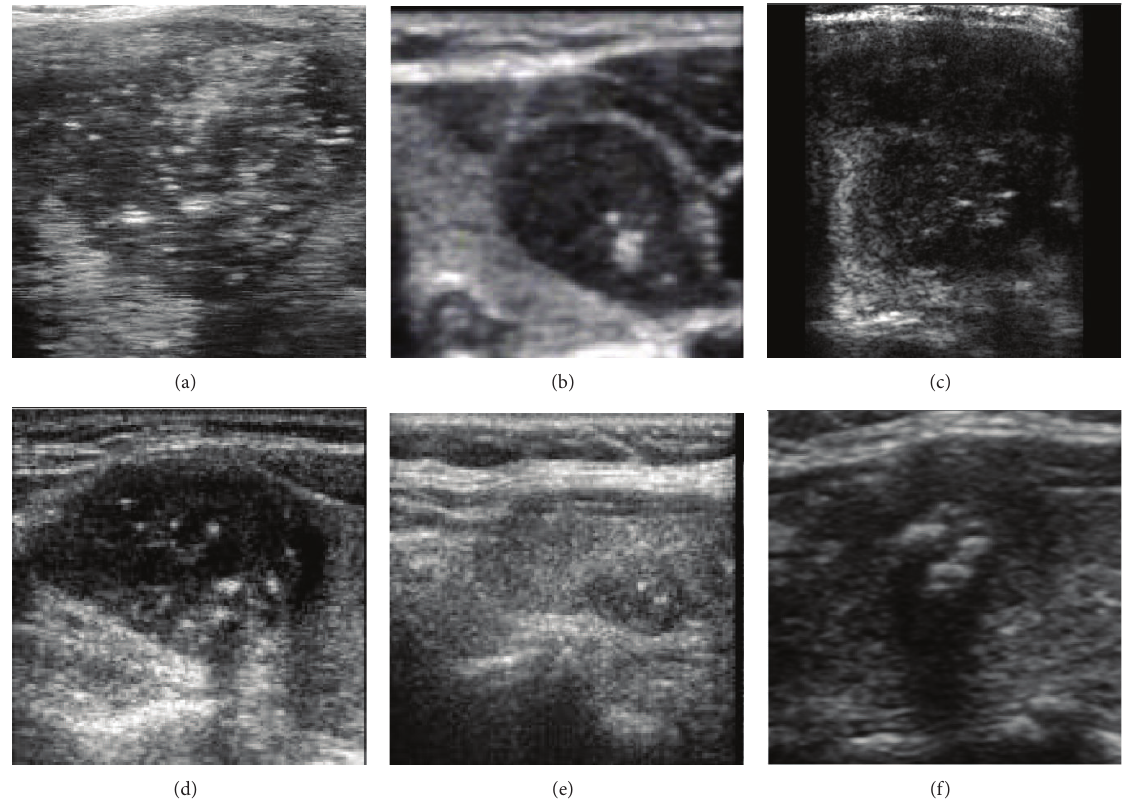
Figure 1: Ultrasonography of medullary cancer. (a)–(c) medullary cancer, (d)-(e) papillary cancer, (f) oxyphilic adenoma. Compare the large irregular patchy hyperechogenic foci in images (a)–(d) with thefew brightSmall spotsof microcalcifications < than 1 mm in maximal diameter in image (e). In contrast to macrocalcifications (image (d) and (f)), they do not indicate dorsal acoustic shadow according to the entire extent of the hyperechogenic focus.